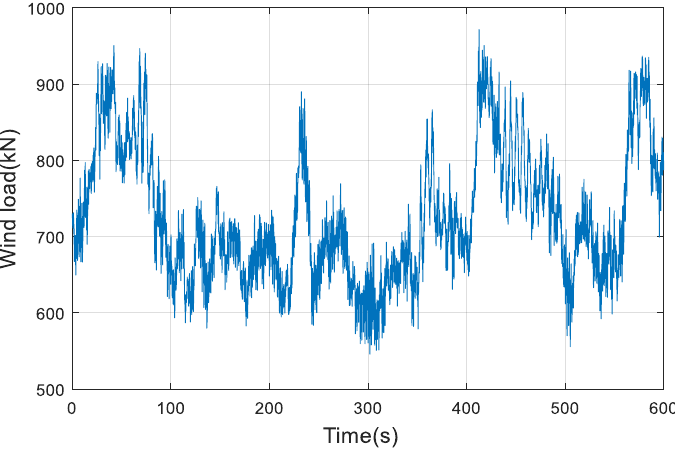
Figure 12. Earthquake motions: ( a ) El Centro(1940); ( b ) Ofunato(1978); ( c ) Hachinohe(1968).